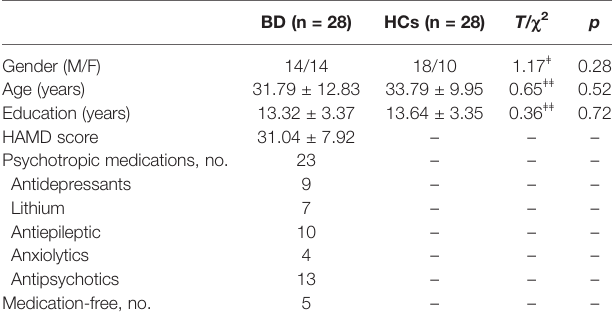
TABLE 2 | Demographic and clinical characteristics of BD and HCs